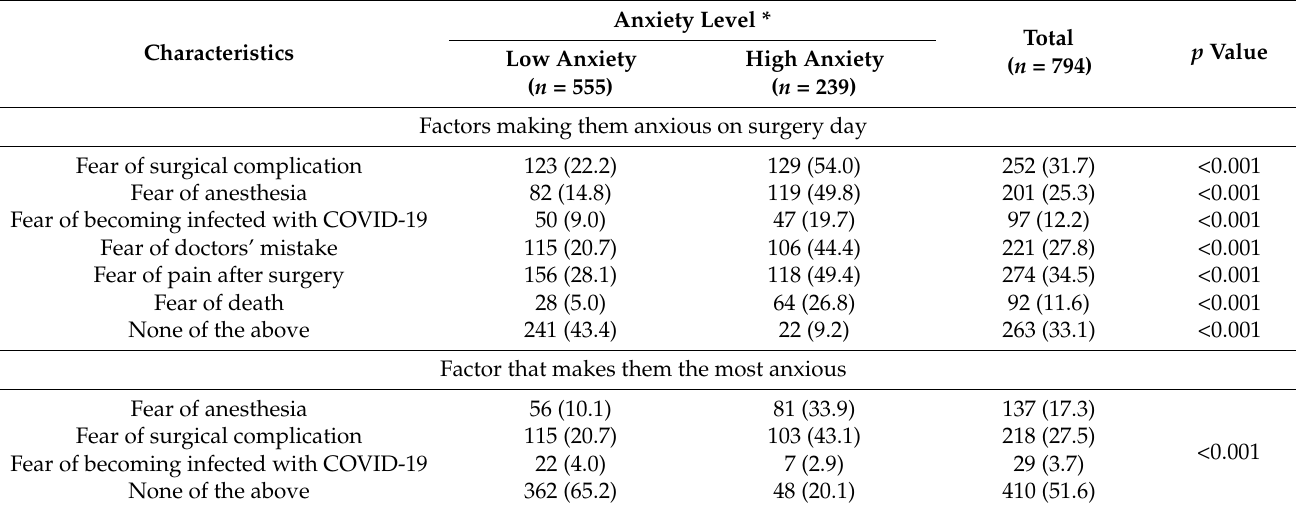
Table 3. Factors associated with preoperative